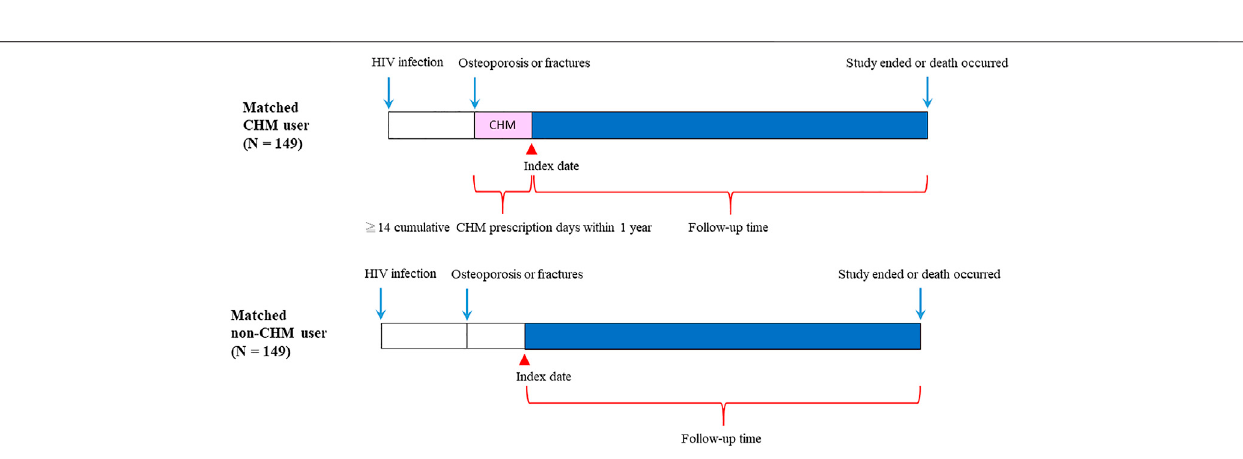
Frontiers in Pharmacology |